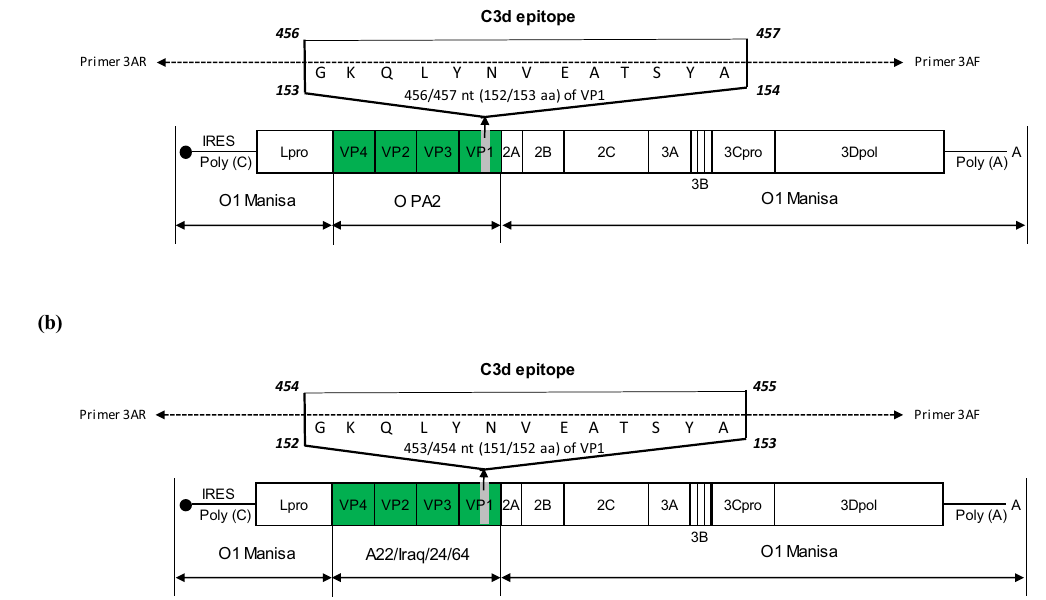
Fig. 1 Construction of the immune-enhancing FMDV vaccine strains, O PA2-C3d and A22-C3d. ( a , b ) O PA2-C3d ( a ); A22-C3d ( b ). The B cell epitope, C3d (with 13 amino acid residues in the VP1 region) is used to prepare the virus. The O PA2 (O PA2-R) or A22 (A22-R) P1 strains — where the P1 region of O1 Manisa is substituted with O PA2 P1 or A22 P1 — are used as the backbone to prepare the immune-enhancing FMD vaccine strains that can overcome interference by maternally-derived